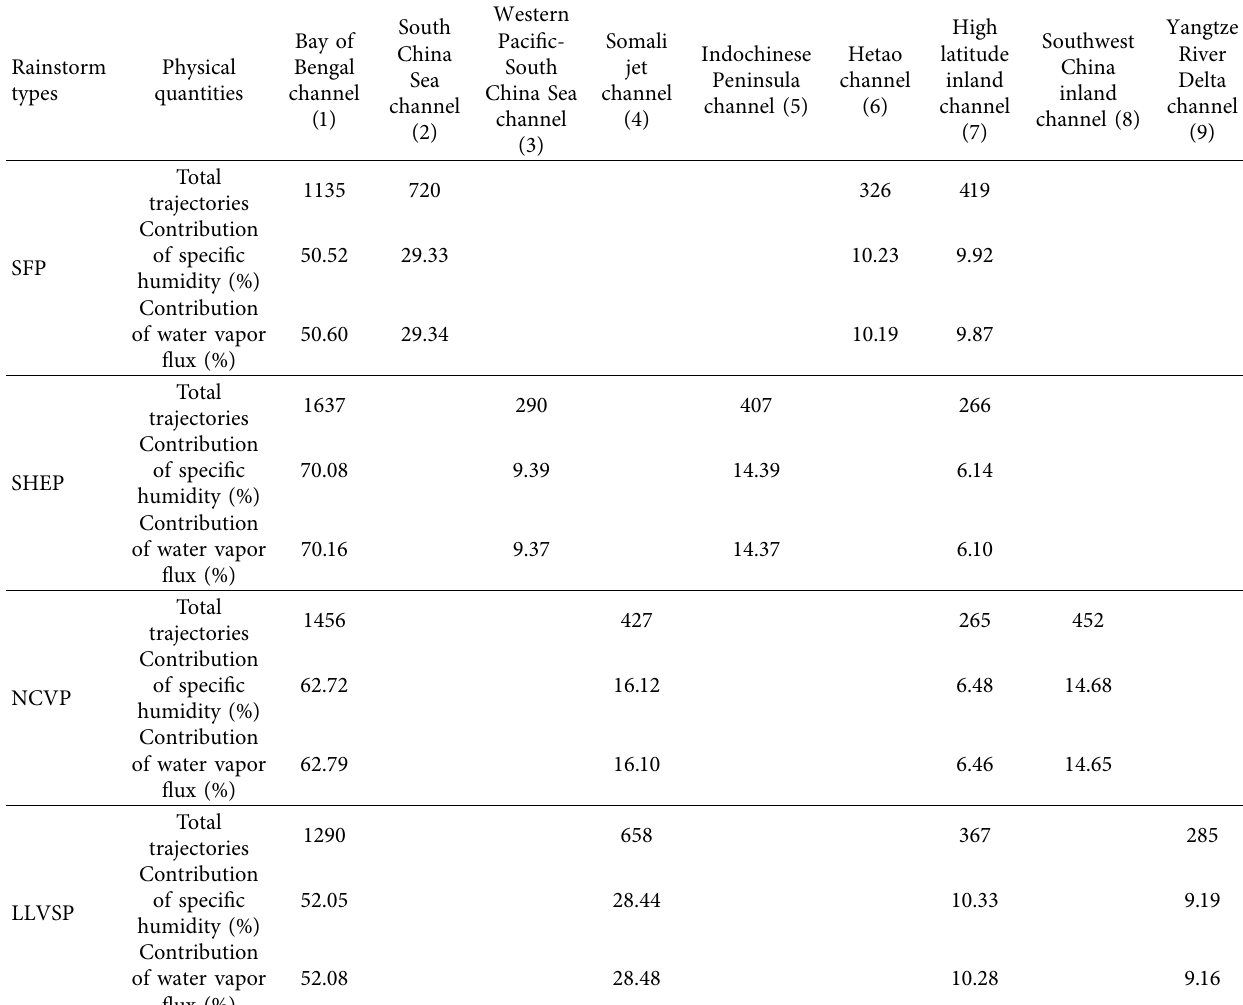
Table 2: The total number of trajectories and contribution of specific humidity and water vapor flux on the middle levels of different types of